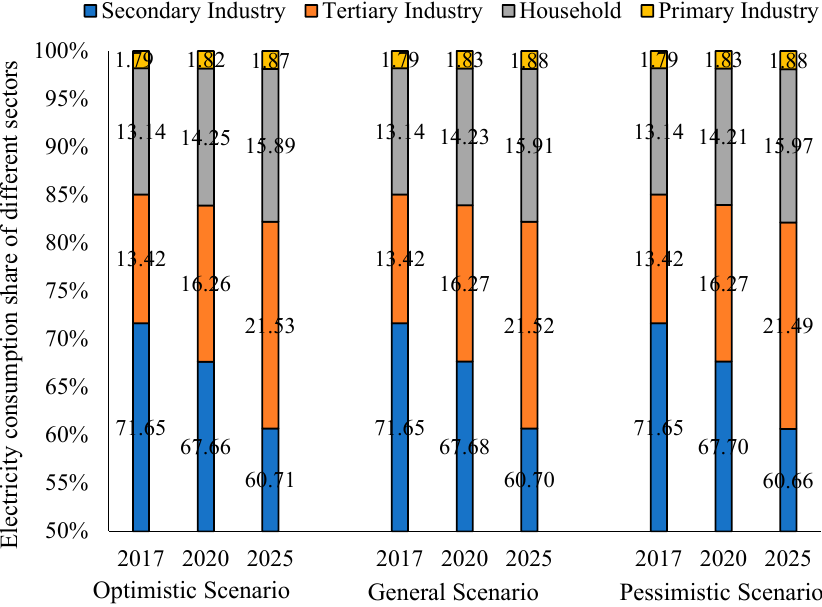
Figure 4. Electricity consumption share of different sectors at the national level.